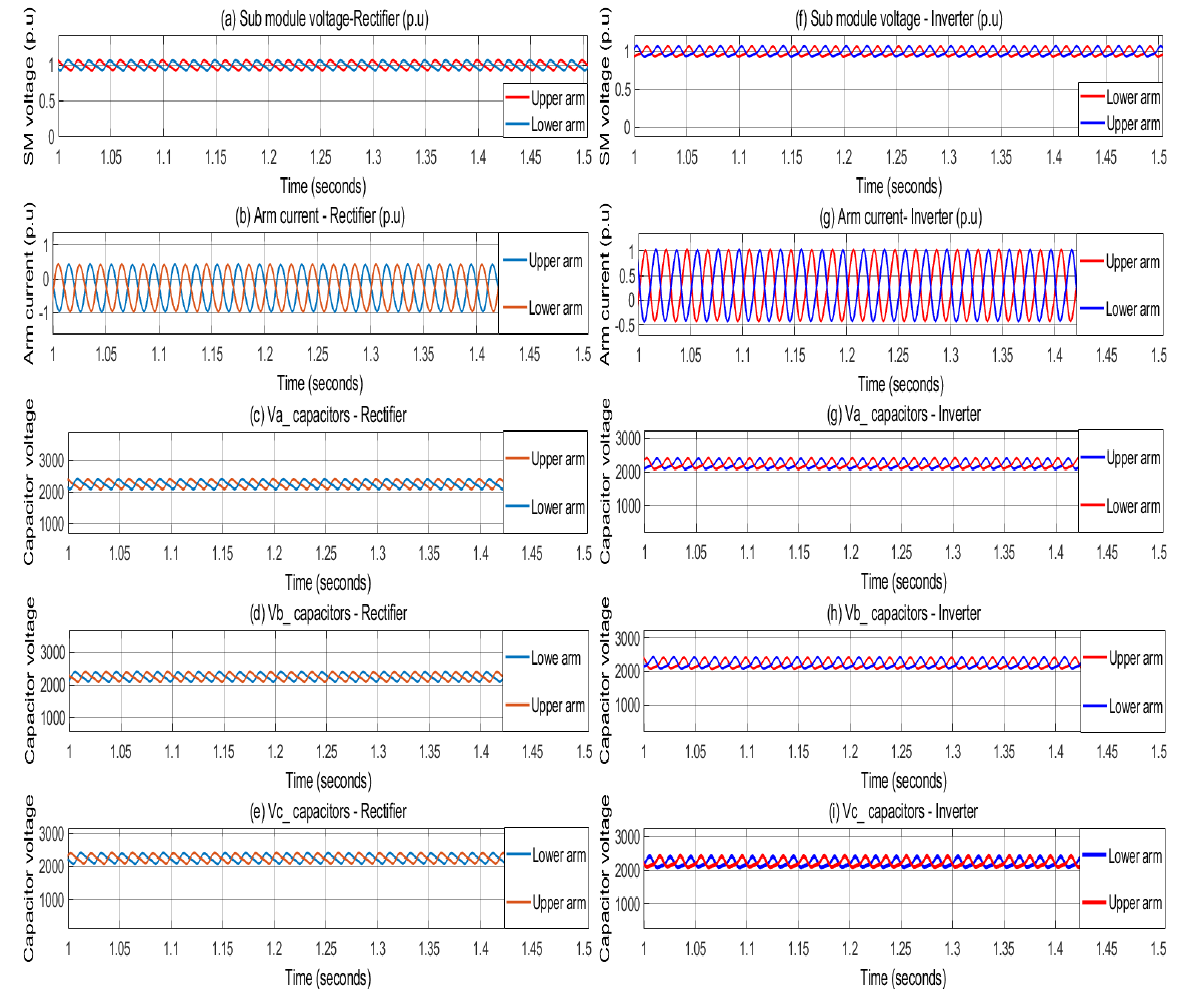
Figure 19. Steady state operation of the MMC-rectifier and the MMC-inverter with SMs voltage, current, and capacitors voltage.